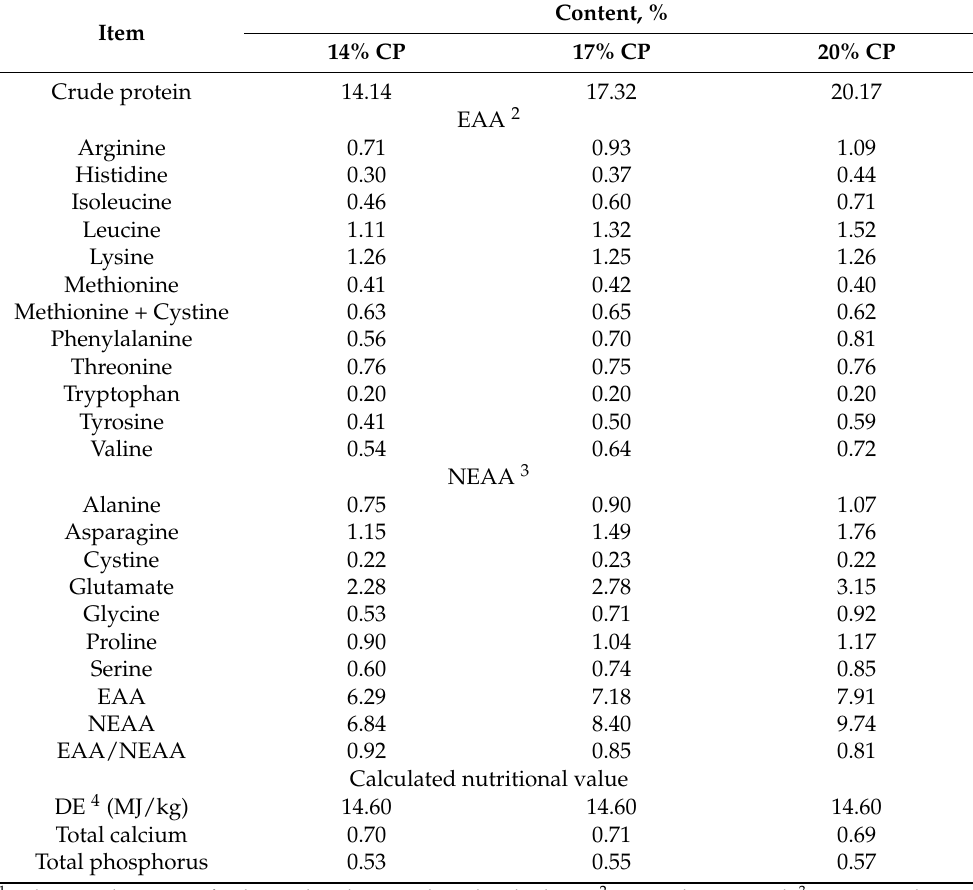
Table 1. Crude protein content and amino acids composition of the experimental diets 1